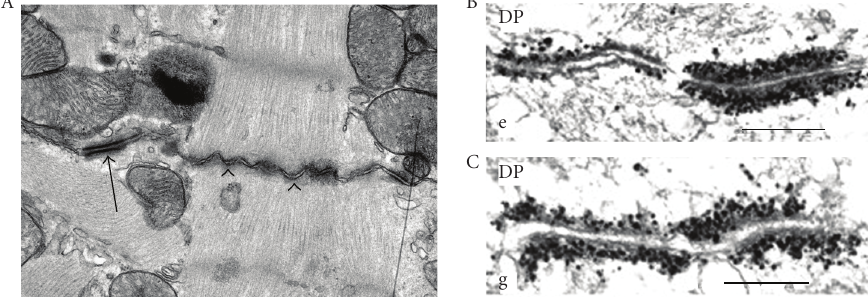
Figure 1: (A) Transmission electron microscopy of intercalated disc in the normal mouse heart, showing the plasma membranes of the adjacent cardiomyocytes with a region structurally resembling a desmosome (arrow) anchoring intermediate filaments, and fascia adhaerens-like structure anchoring predominantly bundles of actin filaments (arrowheads). (B) and (C) Immunoelectron microscopy of the myocardium of mouse heart, showing desmoplakin (DP) antibody labeling with silver amplification at cell-cell junctions. Note that DP immunogold label is enriched in plaques of the junctions. Higher label intensity of DP is desmosome-like structure (the right hand junction in Figure 1(B)), and the fascia adhaerens-like junction is shown in less intensity of DP labeling (the left hand junction in Figure 1(B)). A continuous and equal intensity of DP labeling shows the hybrid junctions (Figure 1(C)) [16]. Figures 1(B) and 1(C) was originally published